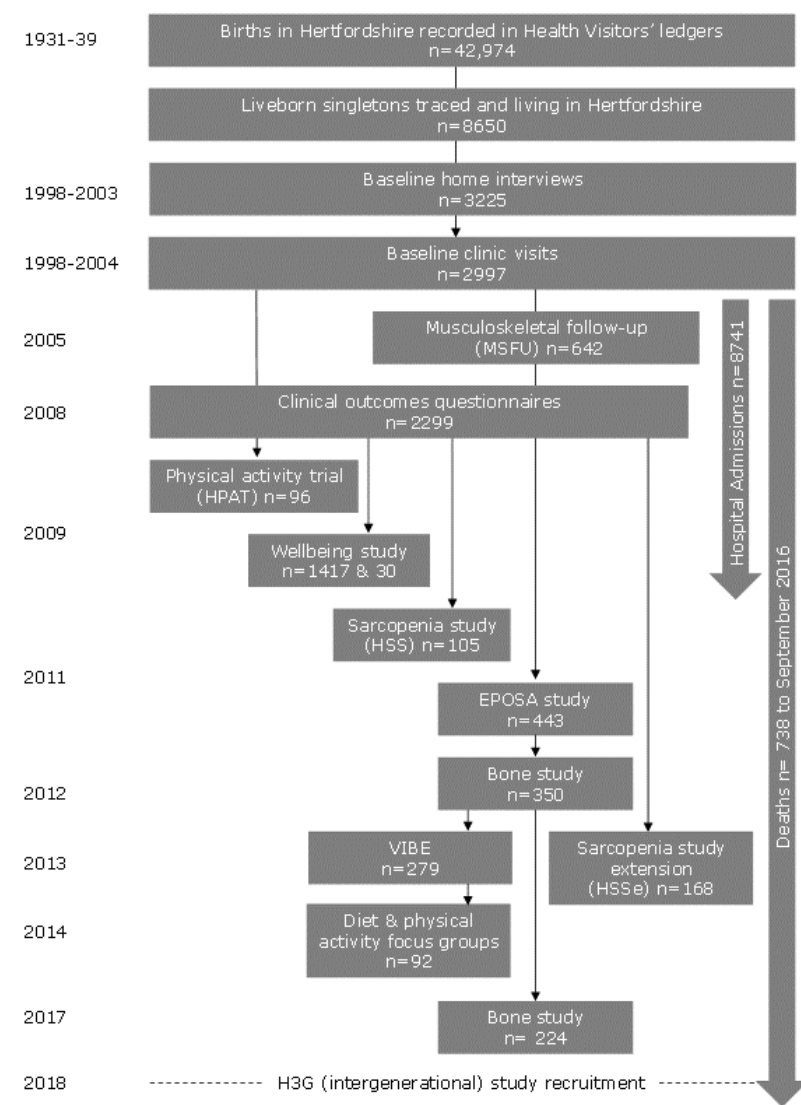
Figure 2. Participant recruitment and summary of studies carried out from 1998–2018.